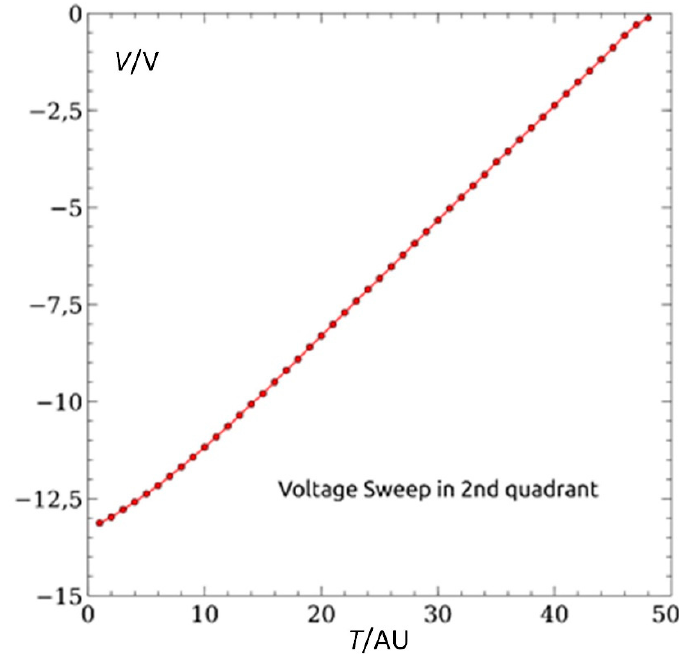
Figure 24. Voltage sweep in the second quadrant (voltage vs. time). AU: arbitrary